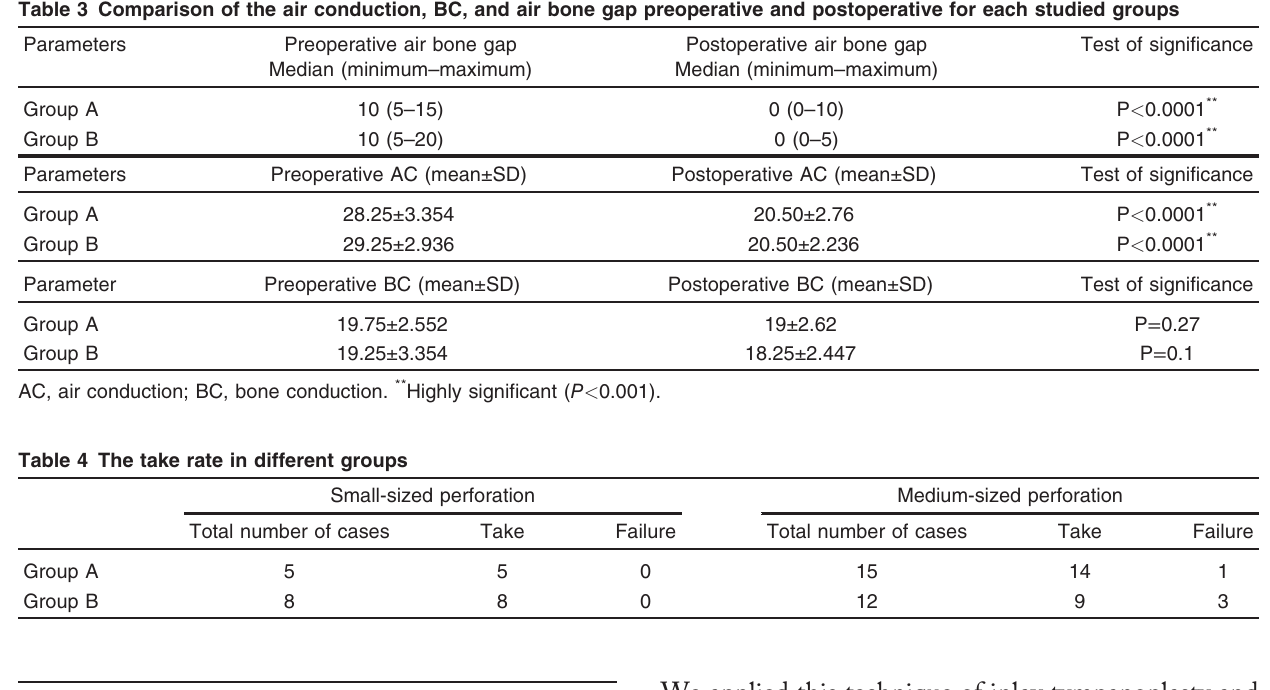
**Most indicative points of improvement.